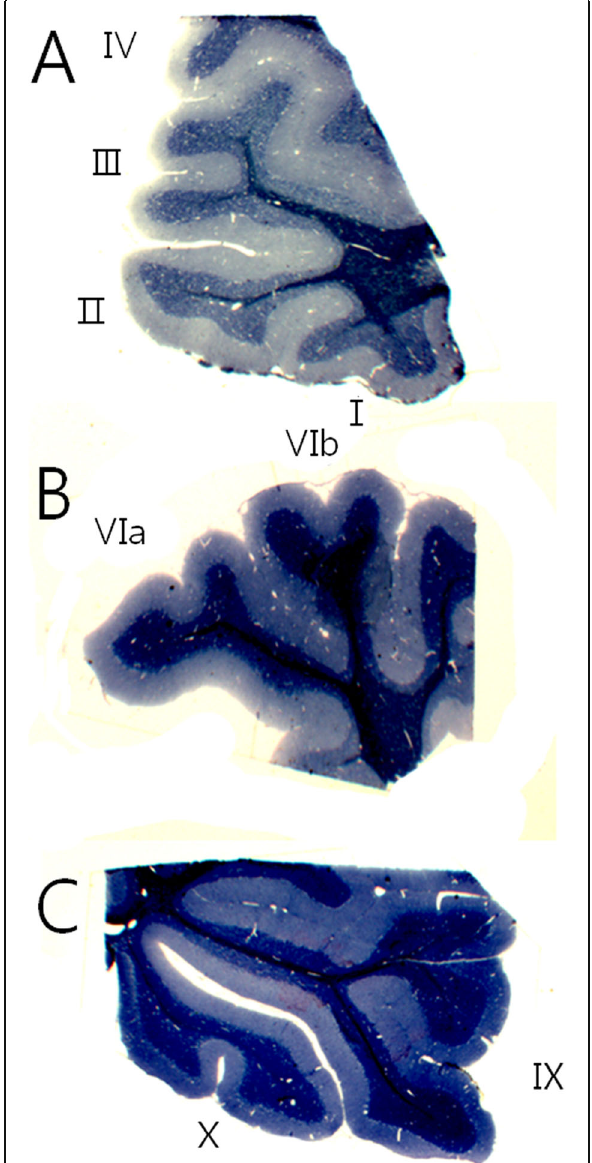
Fig. 1 Image of sagittal section of the cerebellar vermis. The cerebellum is classified phylogenetically into archicerebellum, paledcerebellum and neocerebellum. The images based on light microscopy according to lobule.